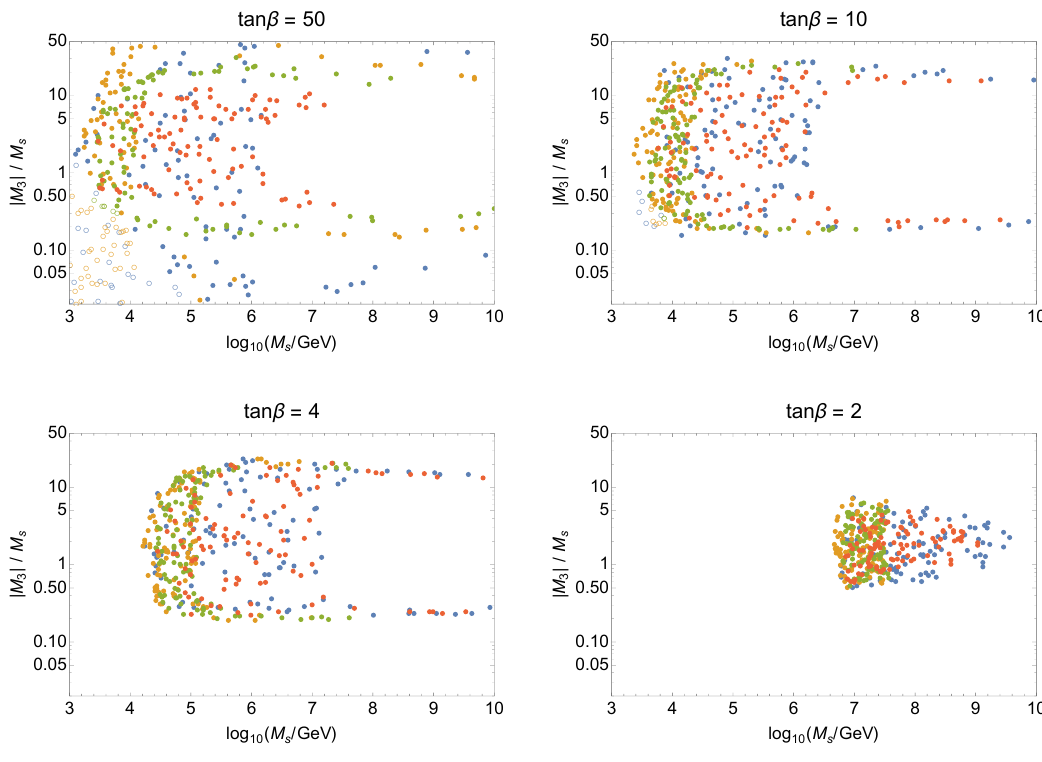
Figure 2 . Same as (cid:12)gure 1, now projected onto (log M s ; j M 3 j =M s )